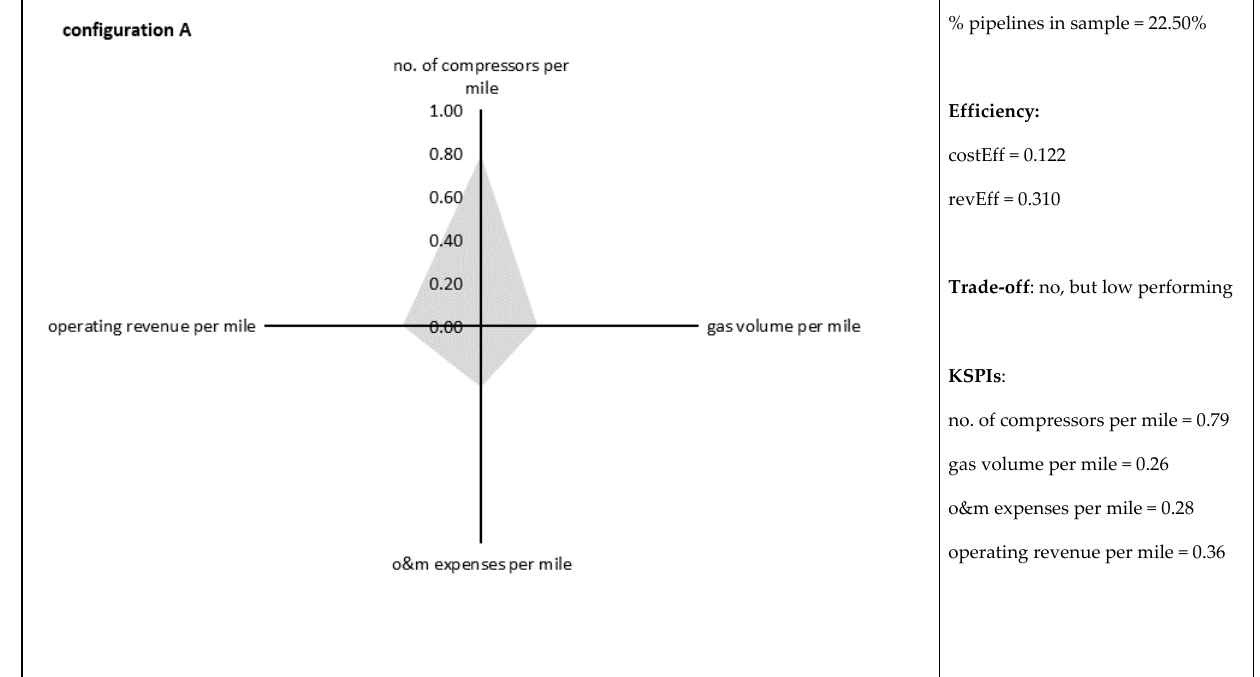
Figure A1. Comparison of gas transmission